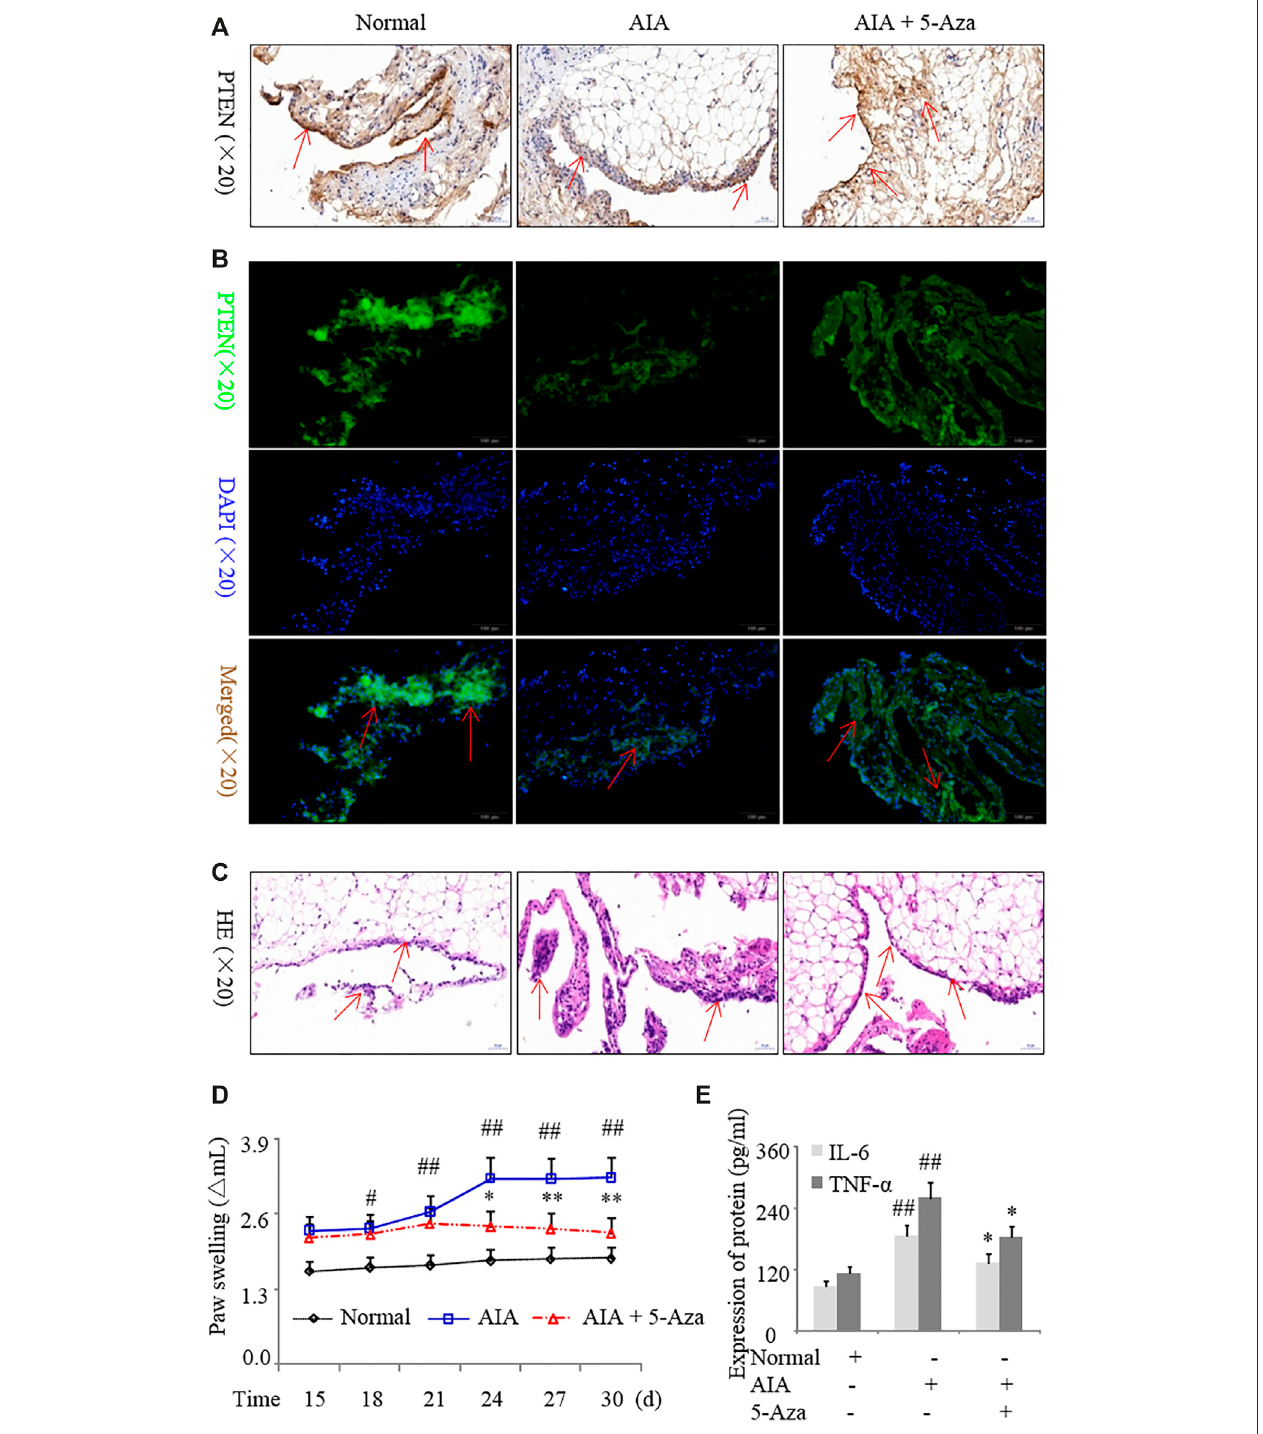
FIGURE4| InhibitionofDNAmethylationsuppressesin fl ammationinaratmodelofAIA.AIAratsweretreatedwith5-azadC(0.7 mg/kg)byintraperitonealinjection. (A, B) Representative images of PTEN immunoreactivity in the synovium detected by immunohistochemistry (A) and immuno fl uorescence labeling (B) . (C) Representativeimagesofhematoxylinandeosinstaininginthesynovium. (D) Pawswelling. (E) SerumIL-6andTNF- α proteinlevelsdetectedbyELISA.Valuesrepresent mean ± SD. # p < 0.05, ## p < 0.01 vs. normal group; * p < 0.05, ** p < 0.01 vs. AIA group.